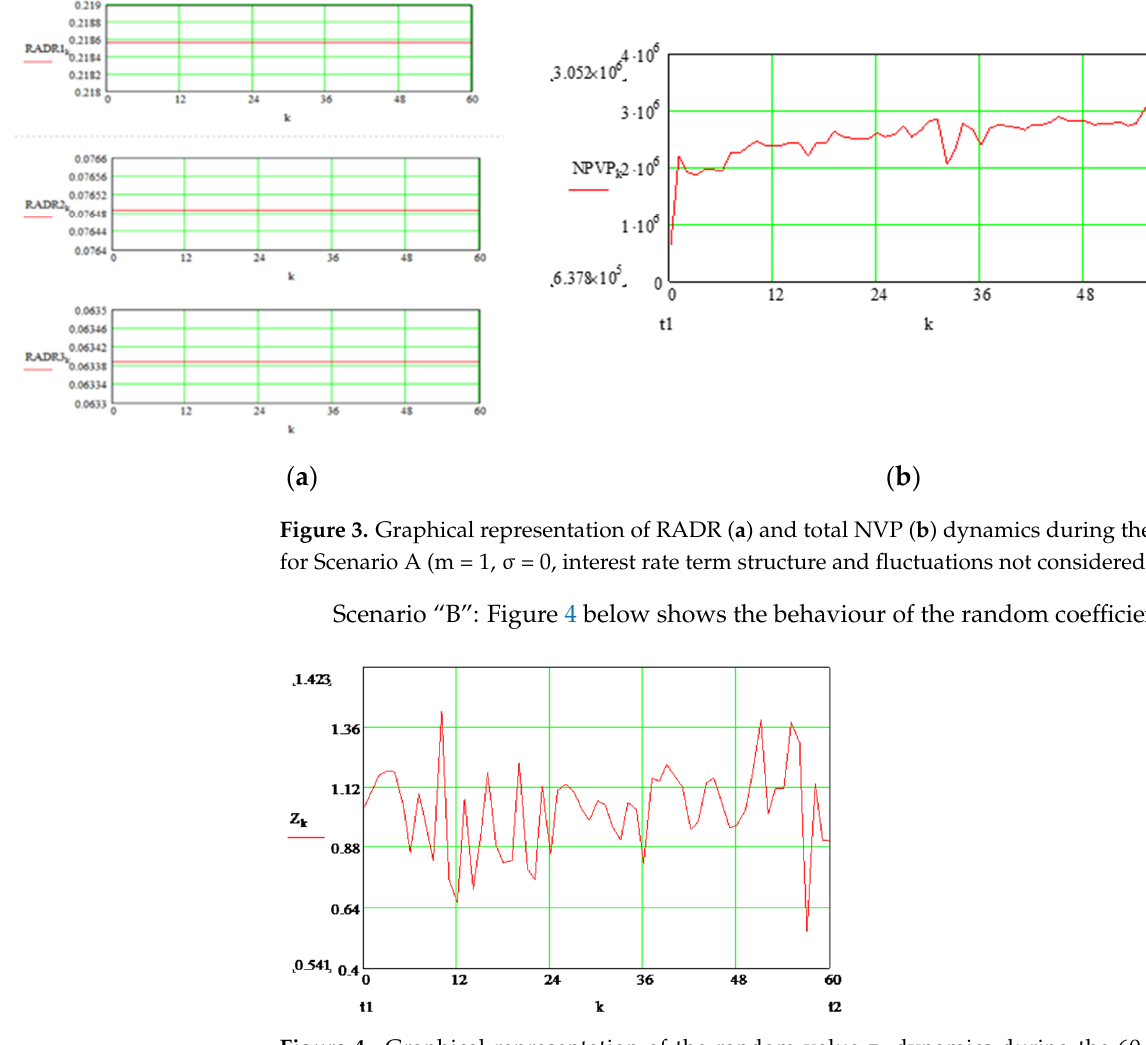
Figure 2. Total Free Cash Flow (FCF1 + FCF2 + FCF3) projection for the period of 60 months. In scenario “A”, no random deviations were taken into account, and the NPV was as in Figure 3. In this scenario, RADRs remained stable throughout the whole period, and all the NPV deviations were related to the demand factors and endogenous factors deviations.